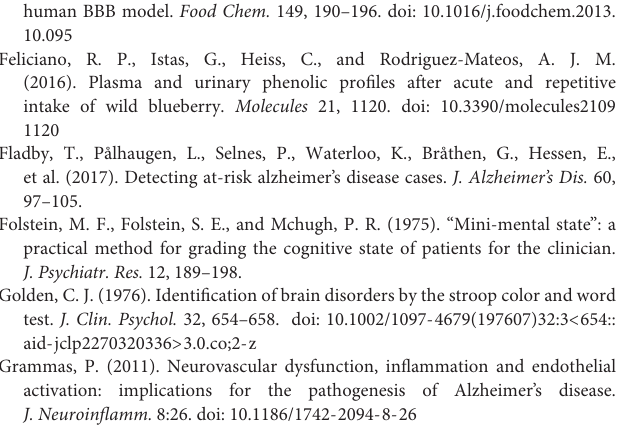
FIGURE S1 | Changes from baseline to 16 weeks follow-up in serum lipids, for participants with anthocyanin supplementation. mmol/L, millimole/liter. FIGURE S2 | Changes from baseline to 16 weeks follow-up in serum fasting glucose and HbA1c, for participants with anthocyanin supplementation. HbA1a, glycosylated hemoglobin; mmol/L, millimole/liter. FIGURE S3 | Changes from baseline to 16 weeks follow-up in serum cytokines, for participants with anthocyanin supplementation. RANTES;CCL-5/RANTES (regulated on activation, normal T-cell expressed and secreted). pg/mL, picomolar/milliliter. FIGURE S4 | Changes from baseline to 16 weeks follow-up in plasma anthocyanin metabolites, for participants with and without anthocyanin supplementation. Measurement unit: nmol/L, nanomolar/liter, except for hippuric acid (nmol/10L) and coumaric acid-4- O - β - D -glucuronide (nmol/0.033L). FIGURE S5 | Changes from baseline to 16 weeks follow-up in CERAD. FIGURE S6 | Changes from baseline to 16 weeks follow-up in Trail Making Test (TMT). Sec, seconds. FIGURE S7 | Changes from baseline to 16 weeks follow-up in Stroop test. TABLE S1 | Changes from baseline to 16 weeks follow-up in serum variables, for participants with supplementation (active) and for control participants. ¯ x , mean; SD, standard deviation; ∗ The within group difference from baseline to study end tested with paired-samples t -test. $ independent samples t -test for the between group differences for (cid:49) (difference from baseline to study end). # With Welch correction for heteroscedasticity. RANTES;CCL-5/RANTES (regulated on activation, normal T-cell expressed and secreted). Diff, mean difference between baseline and follow up results in serum measurements. TABLE S2 | Changes from baseline to 16 weeks follow-up in cognitive variables, for participants with supplementation (active). ¯ x , mean; SD, standard deviation; TMT, Trail Making Test; Diff, mean difference between baseline and follow up results in cognitive tests. ∗ The within group difference from baseline to study end tested with paired-samples t